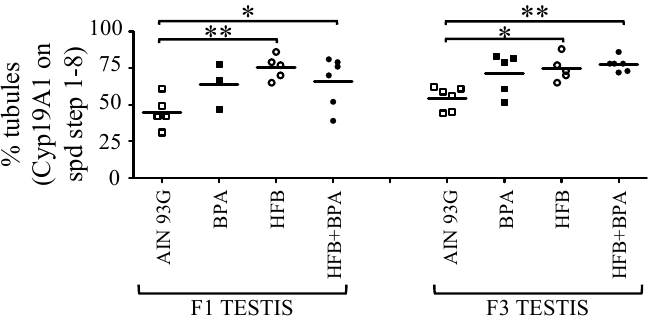
Figure 7. Increased expression of acrosomal CYP19A1 in round spermatids of aged animals, from F1- and F3-generation BPA, HFB, and HFB + BPA groups compared to AIN group. Testis sections were scored for number of STs with acrosomal CYP19A1 in round spermatids. Each symbol represents a pup from an independent litter. * p < 0.05, ** p < 0.01, using one-way ANOVA between groups indicated, followed by Dunnett’s multiple comparison test.